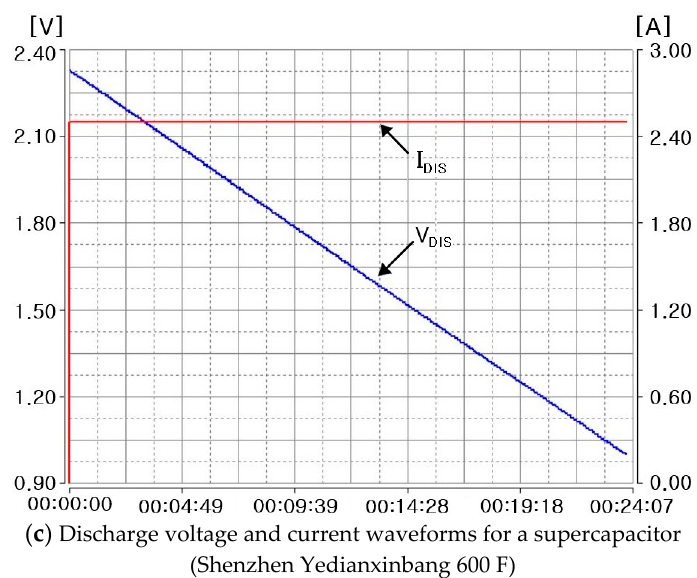
Figure 25. Discharge voltage and current waveforms of Li-ion batteries and supercapacitor.